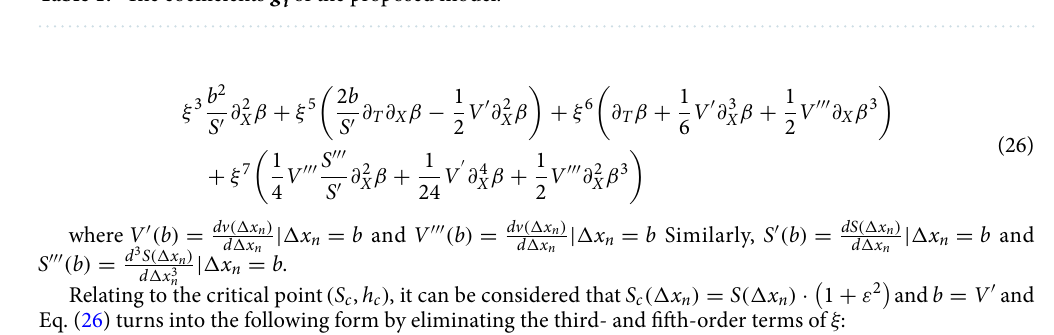
Table 1. The coefficients g i of the proposed